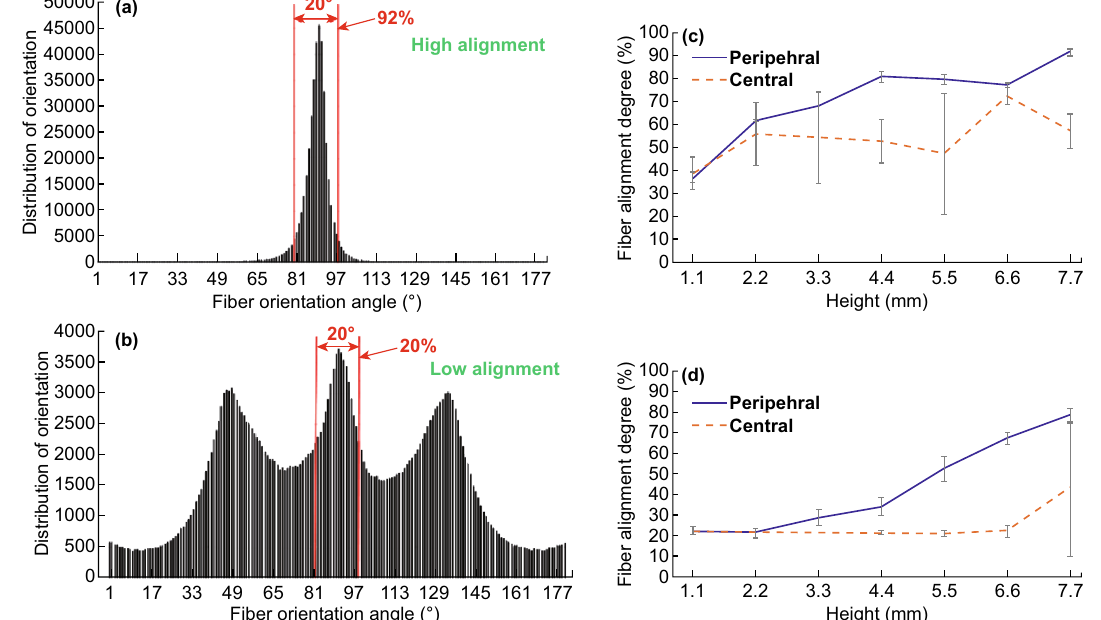
Fig. 6 a A histogram of fiber orientation at 7.7 mm from the bottom of the peripheral area in the 45 (cid:3) -collector. b A histogram of fiber orientation at 4.4 mm from the bottom of the central area in the 60 (cid:3) -collector. Fiber alignment gradients in the c 45 (cid:3) -collector and d 60 (cid:3) -collector